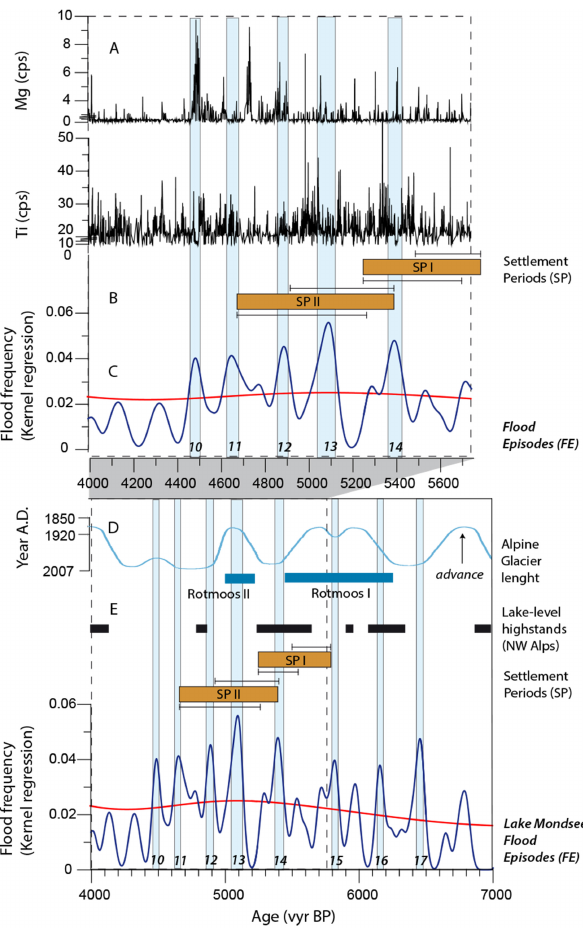
Fig. 6. Comparison of Lake Mondsee sediment data and identified flood episodes (FE 10 to FE 17) with other proxy data. (a) µXRF el- ement scans for Ti and Mg from Lake Mondsee sediments. (b) Set- tlement periods SP I and SP II at Lake Mondsee (bars above and below the respective box indicate radiocarbon dates (as 2 σ uncer- tainty intervals) of the youngest and oldest artefacts from both set- tlement periods). (c) Flood occurrence at Lake Mondsee (Kernel regression with 30 (blue) and 500yr (red) bandwidth). (d) Alpine glacier lengths (Holzhauser, 2007) and phases of the Rotmoos Os- cillation (Bortenschlager, 1970). (e) Lake-level highstands in the NW Alps (Magny,